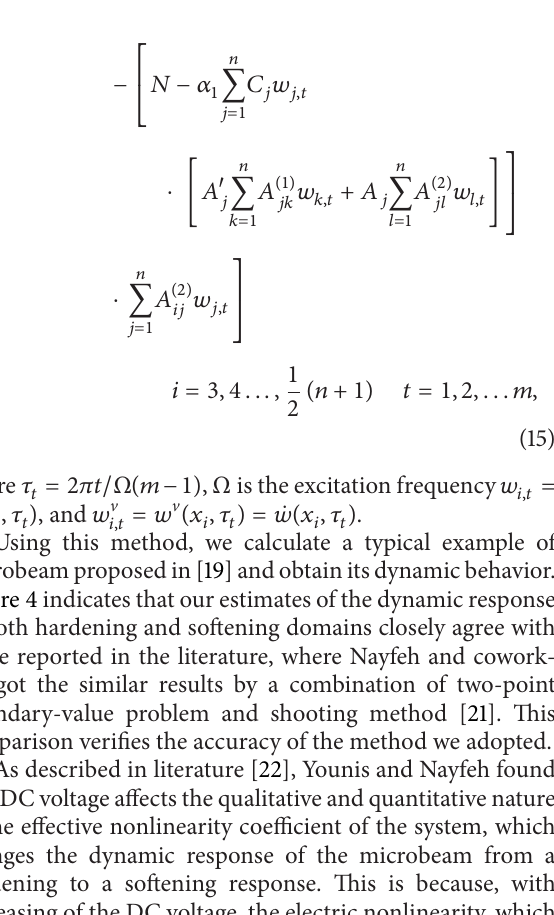
Figure 4: Comparison of the frequency response curve: (a) in the hardening domain ( 𝑉 = 3.5 V, 𝑉 = 0.1 ( 𝑉 dc ac